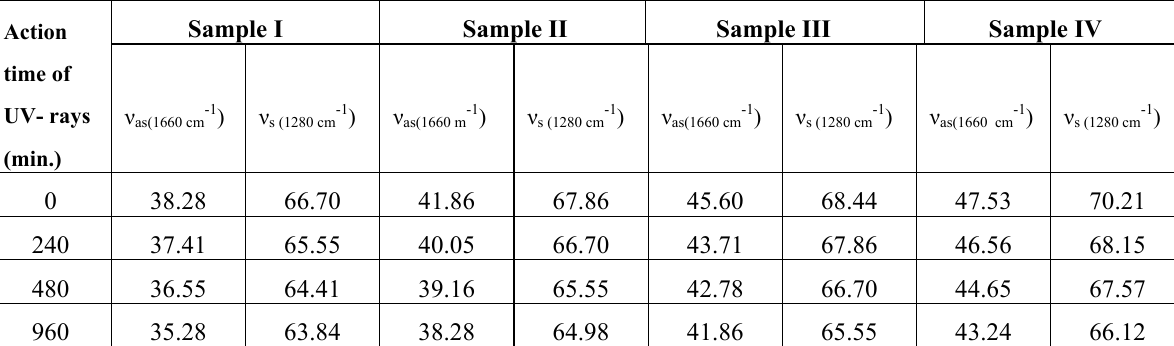
Table 8. Surfaces of the characteristic IR bands of a nitro group for nitrodope samples with different contents of